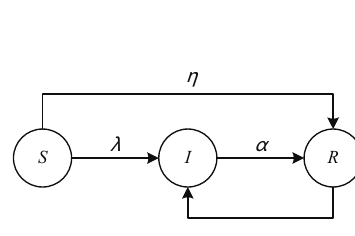
Fig. 1 Node status transition model of SSIR R-I